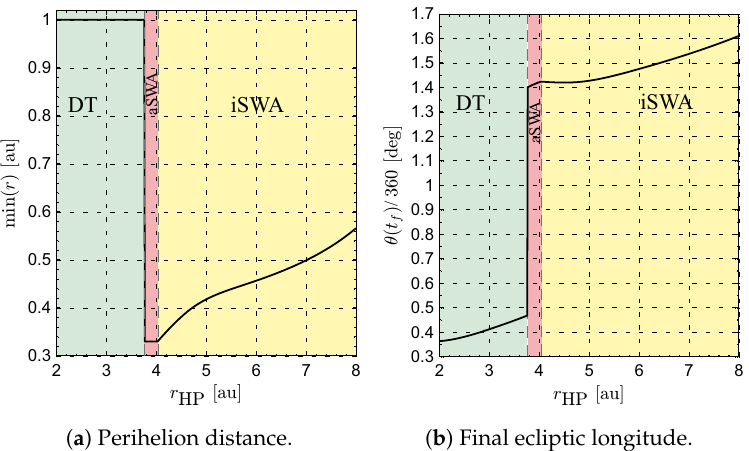
Figure 7. Optimal transfer trajectory characteristics as a function of r HP in a two-dimensional mission scenario.